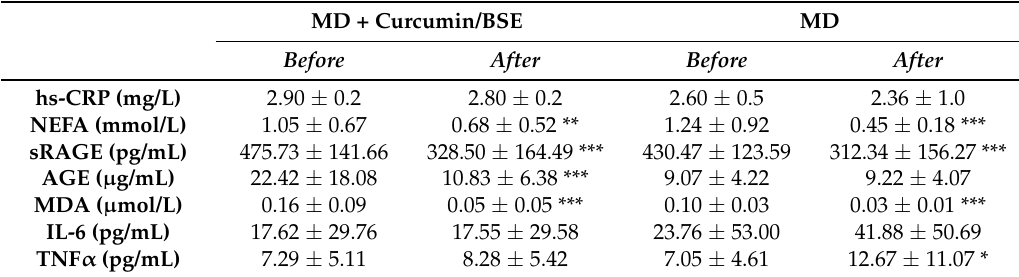
Table 2. Parameters of inflammation and glyco-/lipo-oxidative stress evaluated in the two groups, before and after therapeutic intervention.